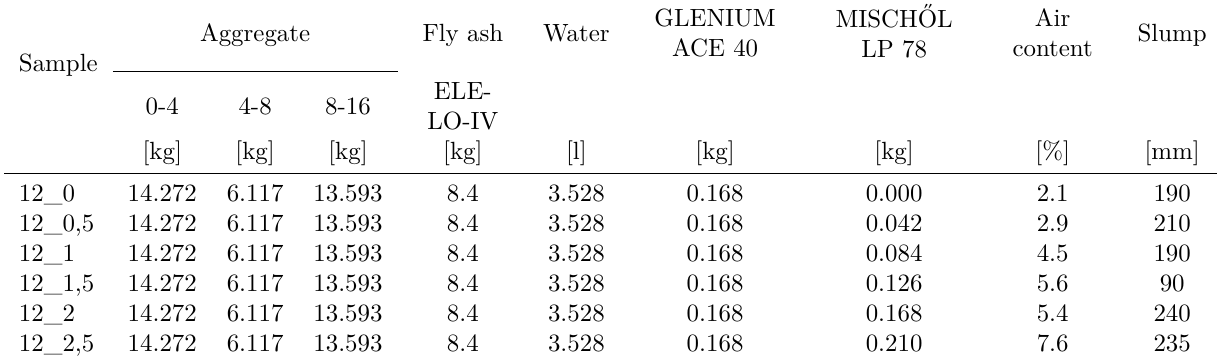
Table 8. Composition of mixtures of the Series no. 12.